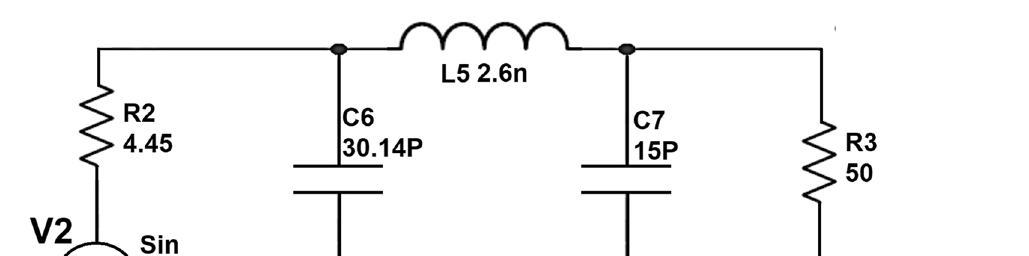
Figure 6. R opt obtained from the waveform calculator.